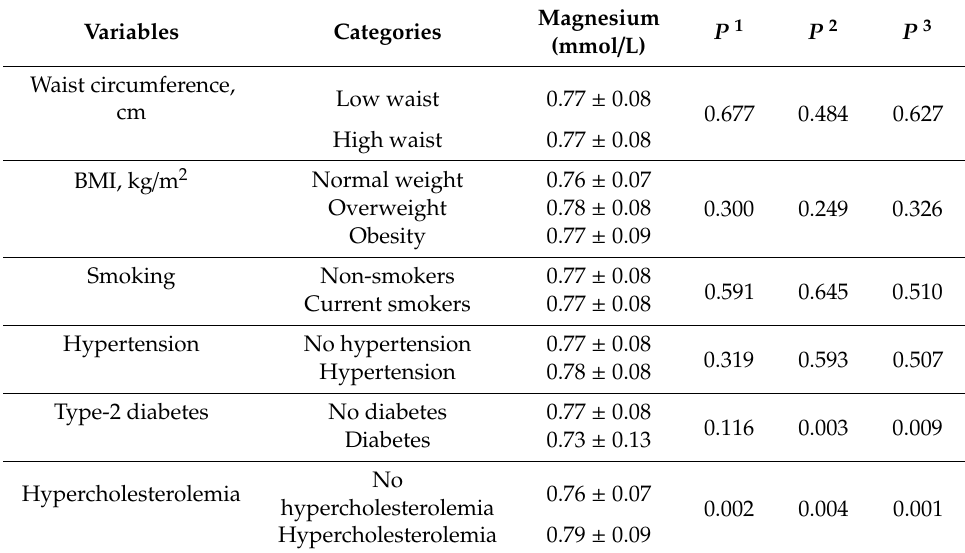
Table 3. Associations between plasma magnesium concentrations and anthropometric and clinical variables in the whole population.